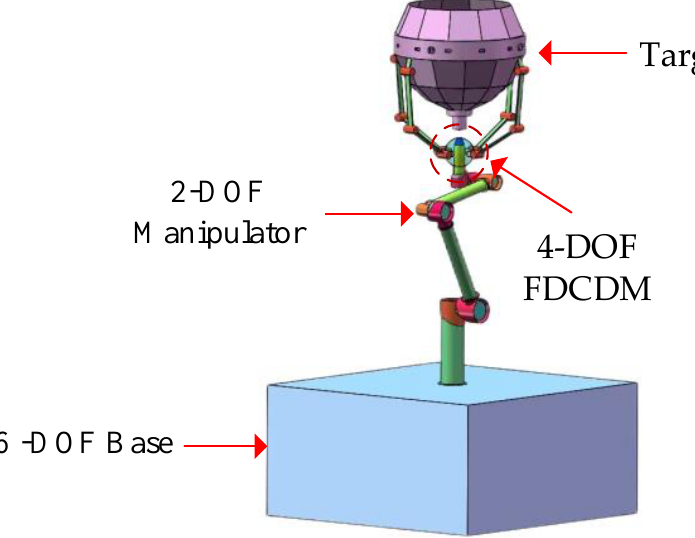
Figure 2. The spacecraft-manipulator system with FDCDM (SMS-FDCDM).